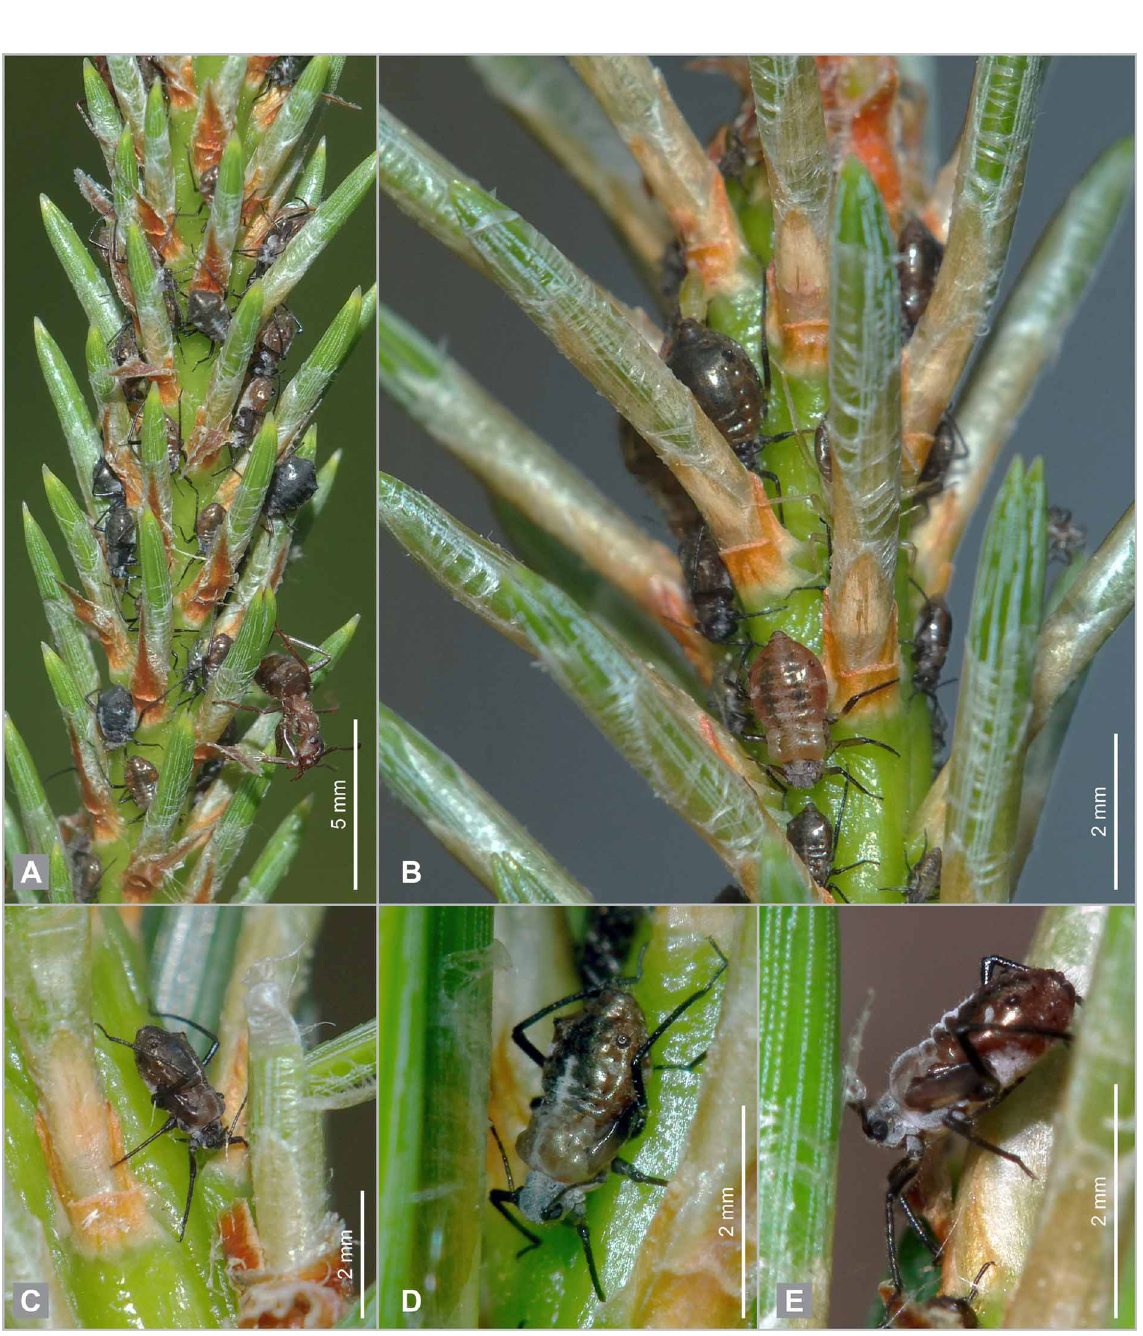
Fig. 107. Cinara (Cinara) hyperophila (Koch, 1855). Colony on young shoot of Pinus sylvestris , attended by Lasius niger (Linnaeus, 1758) . A–B . Adult apterae and juvenile alatae. C–D . Juvenile